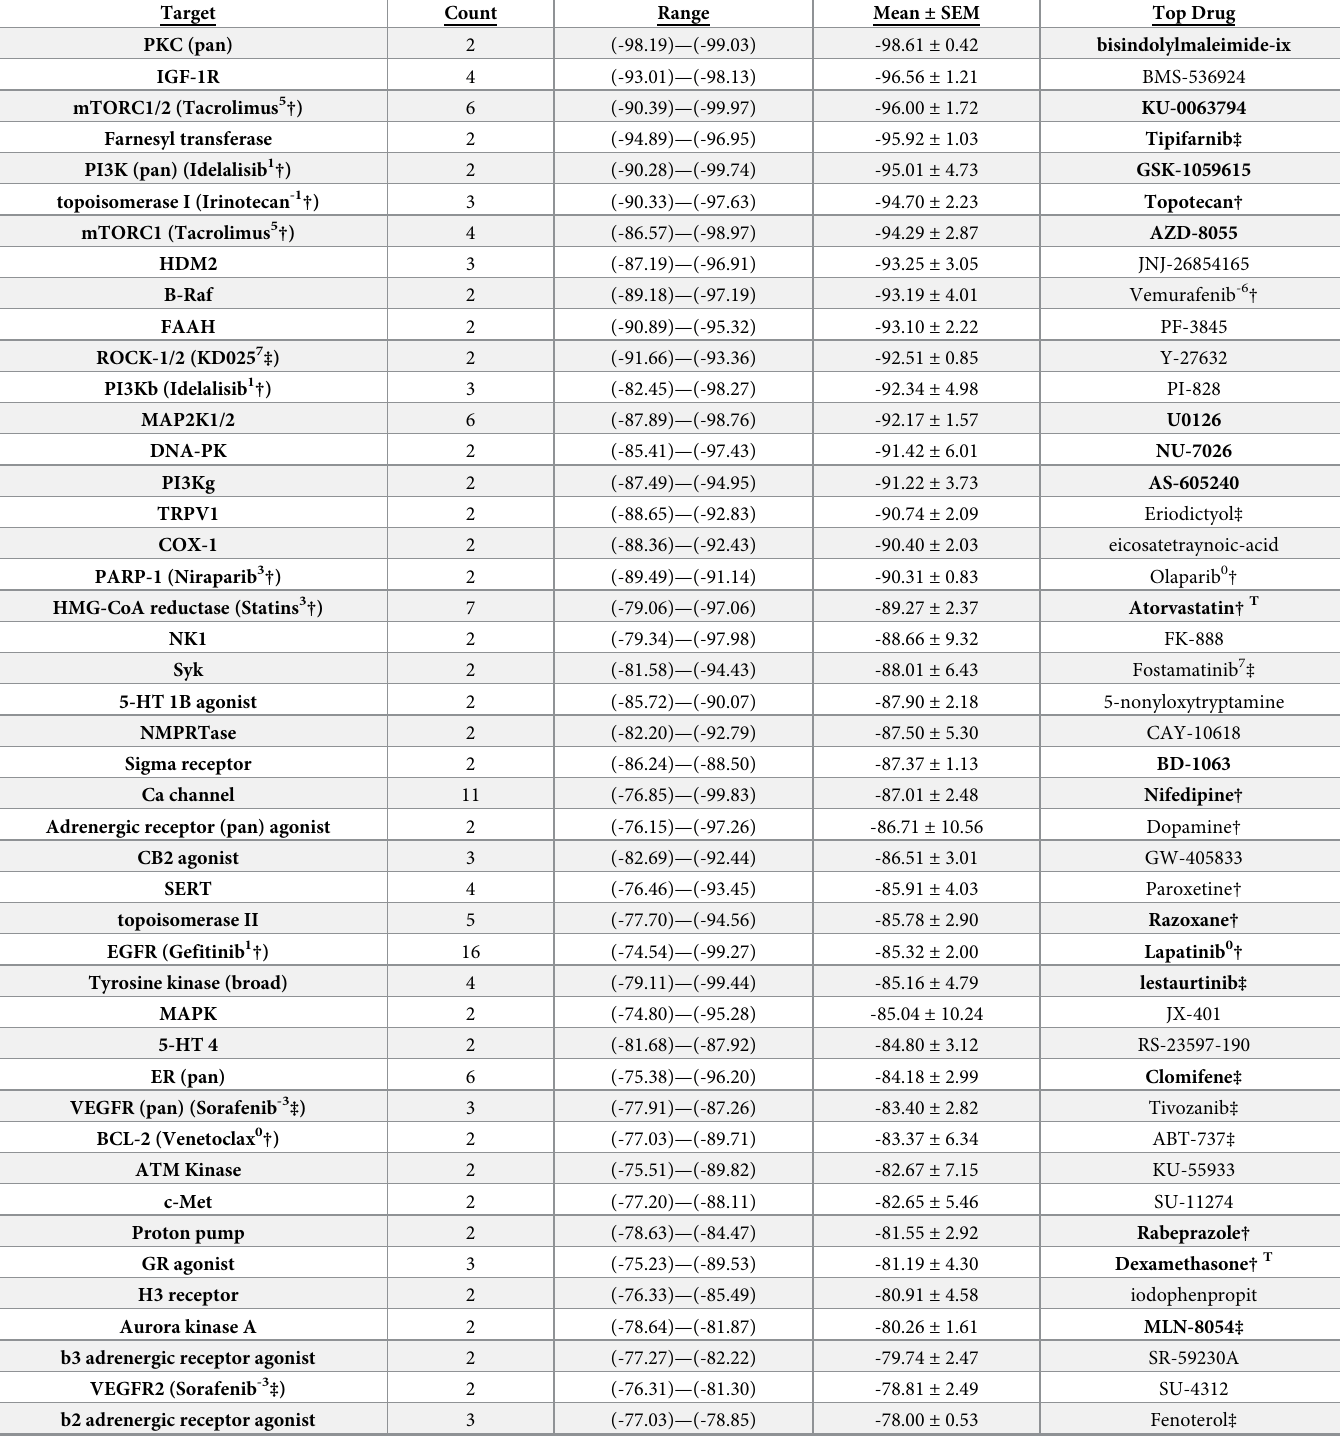
Table 2. Compounds targeting CD14 + monocyte pathways in inactive